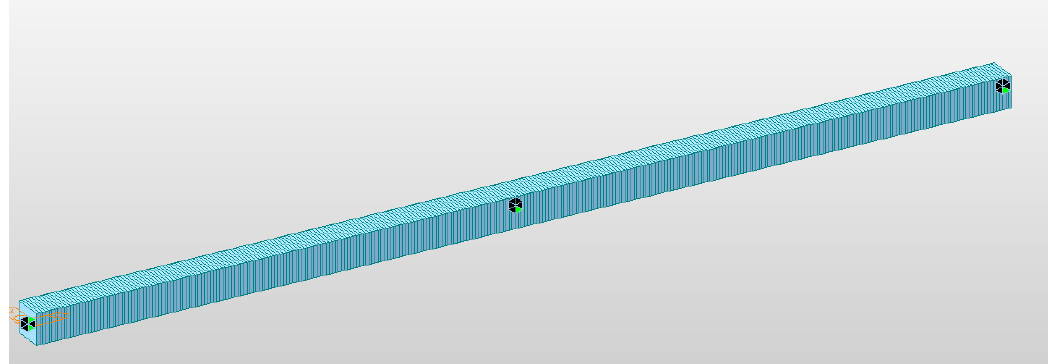
Figure 6. Midas civil model of test continuous beam.